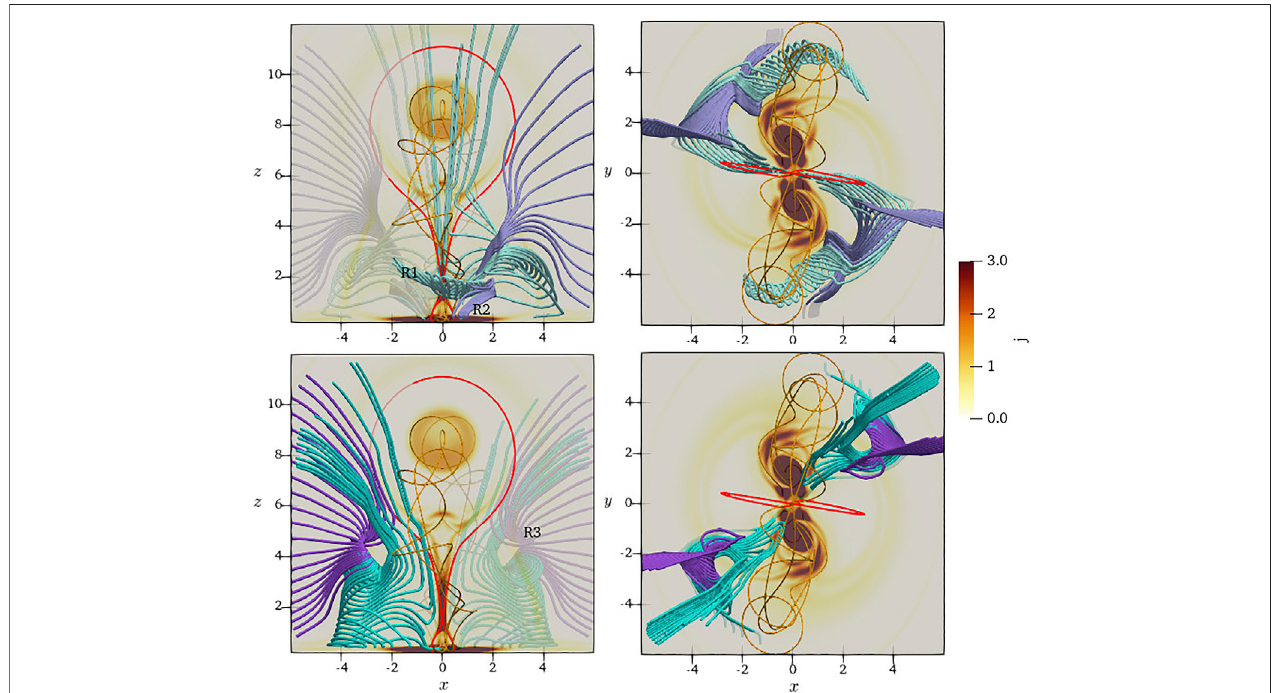
FIGURE 3 | Several groups of velocity streamlines (colorful curves) show complex plasma fl ow fi eld structures around the CME at t (cid:2) 3. Golden curves are the magnetic fi eld line of the MFR; Red curves give the CME bubble boundary (Upper row) The light-green and light-purple curves are velocity streamlines in quadrants II and IV of the x - y coordinate system. (Lower row) The green and purple curves are velocity streamlines in quadrants I and III.